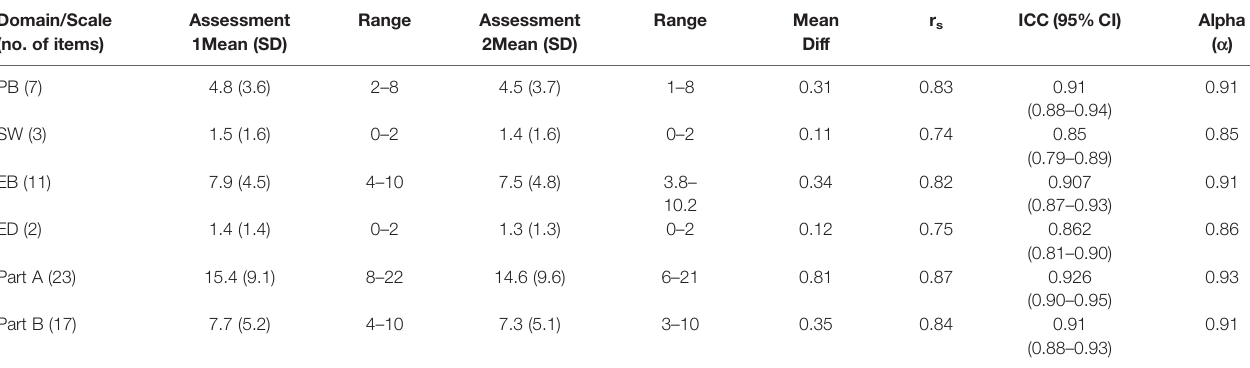
TABLE 2 | Test-retest reliability of the HM-PRO (n =150). Domain/Scale (no. of items)